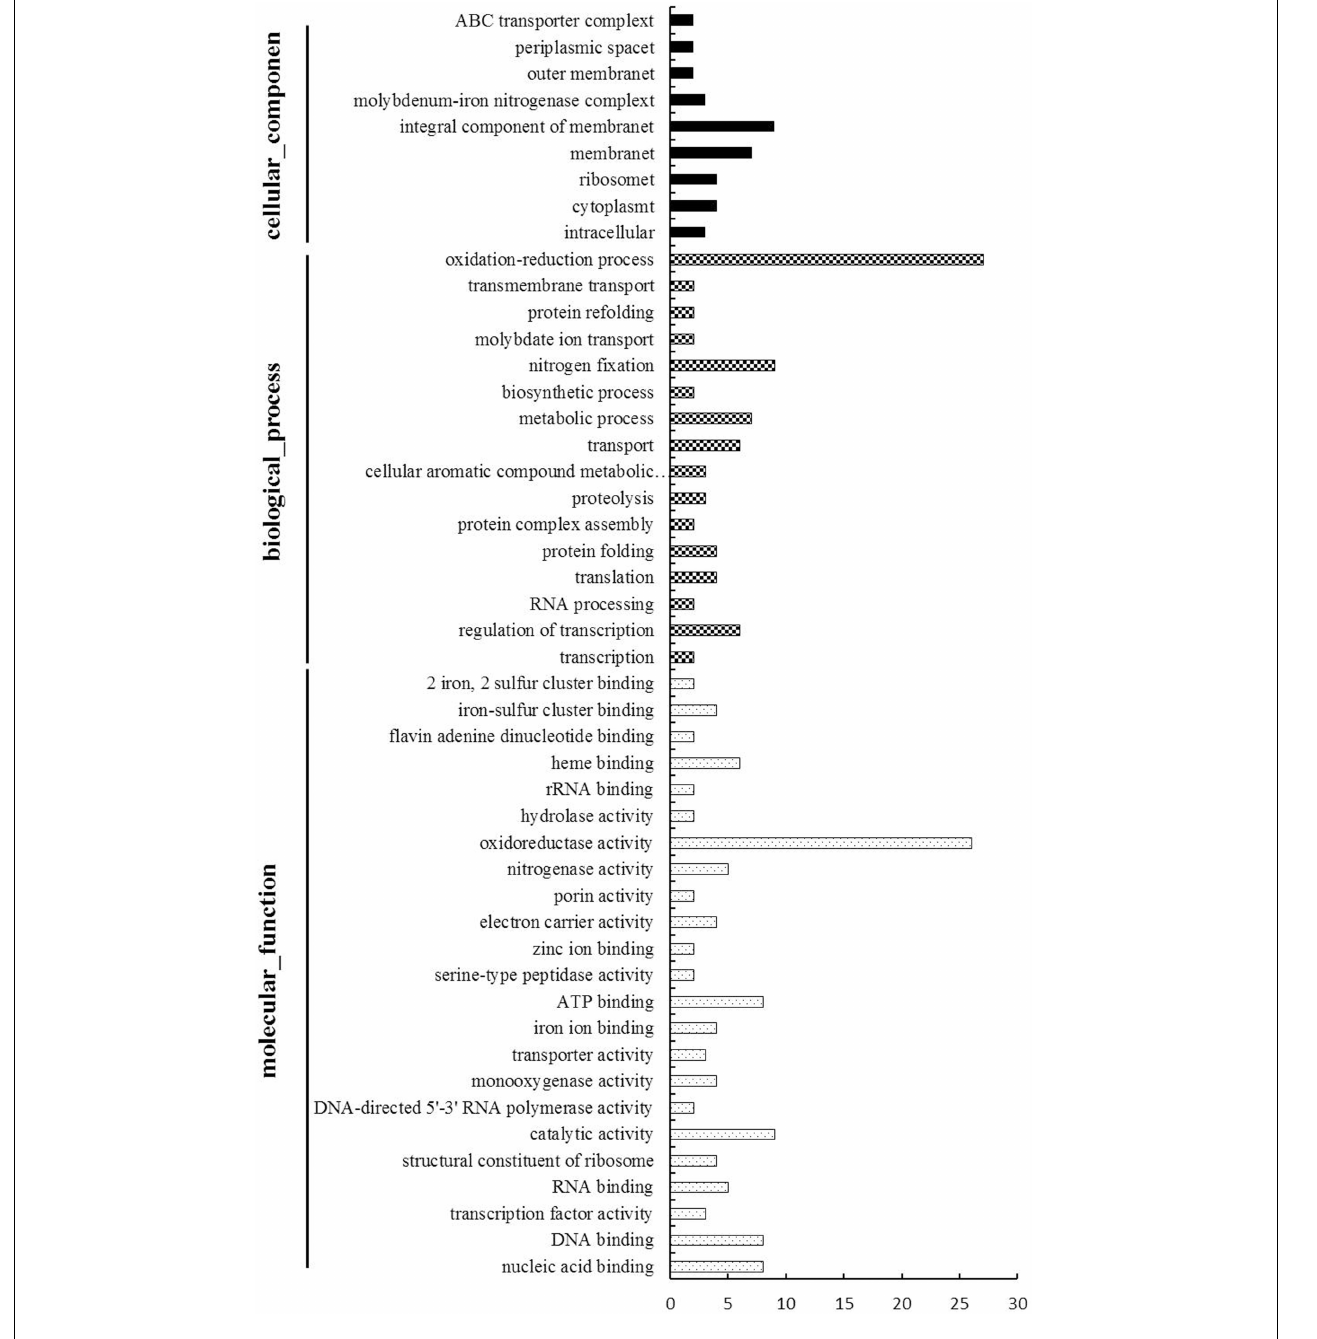
FIGURE 4 | Gene Ontology-based functional annotation of DEGs of B. diazoefficiens 113-2 between different nodules from different developmental periods of soybean. Three GO domains (biological process, cellular components, and molecular function) are shown and the numbers of genes in each term were shown in